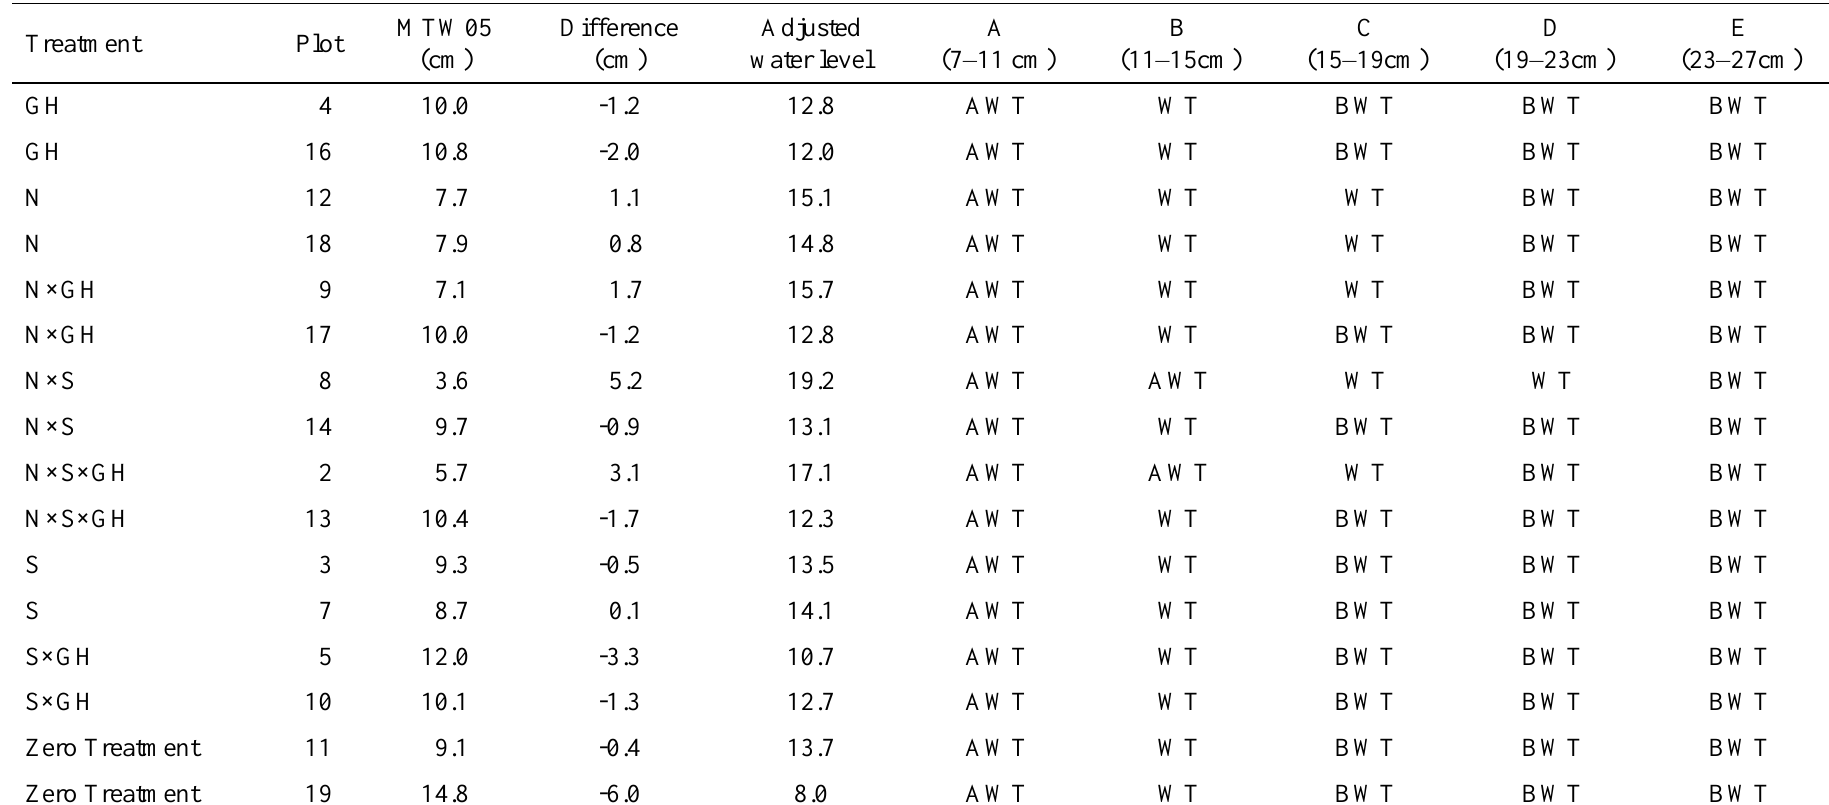
Table A2. Depth normalisation based on plot-specific average values as measured in the years 2004–2006 (Eriksson et al . 2010a). MTW05 = mean water table level in 2005 at each plot. Difference = the MTW05 of each plot subtracted from the overall MTW05 average (8.8 cm). Adjusted water level = Difference added to 14 cm (corresponding to the 2004–2006 mean annual water table level). A–E: sampled depths classified to horizon in the peat profile: AWT = above the annual mean water table level, WT = around the annual mean water table level, BWT = below the annual mean water table